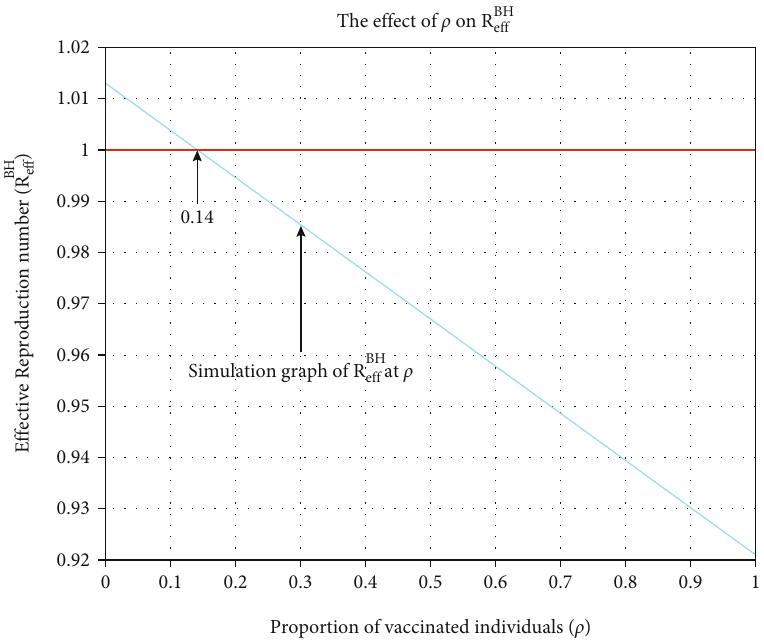
Figure 14: Simulation of the reproduction number of HBV-HIV/AIDS coinfection at a variable proportion of vaccinated individuals ρ .